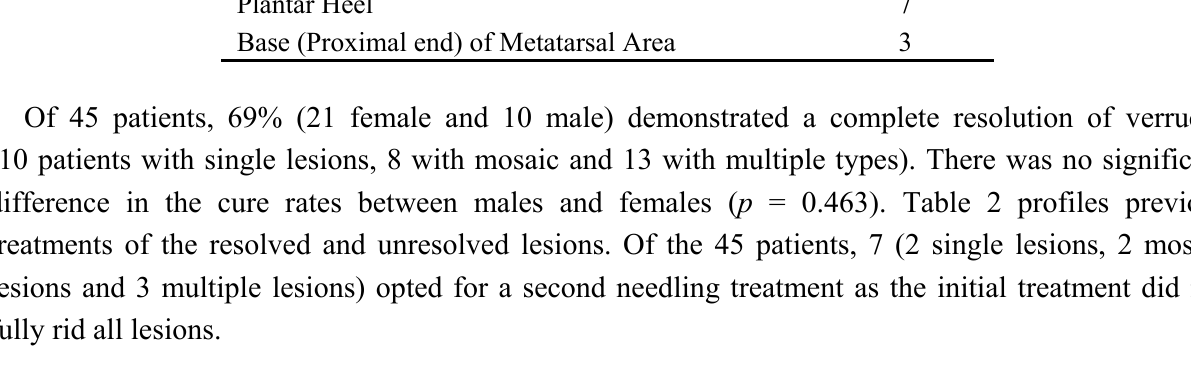
Table 2. Previous treatment profile of resolved (R) and unresolved (U) lesions ( n =